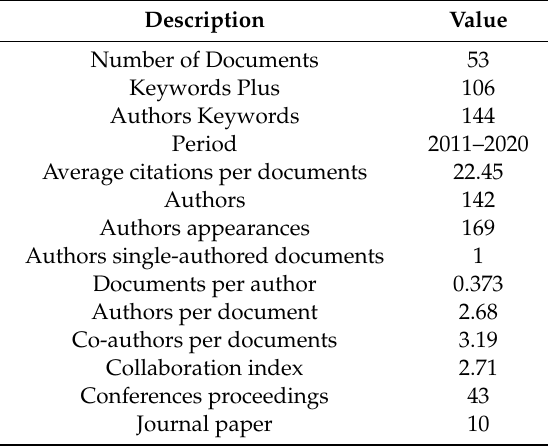
Table 8. Main information about data.